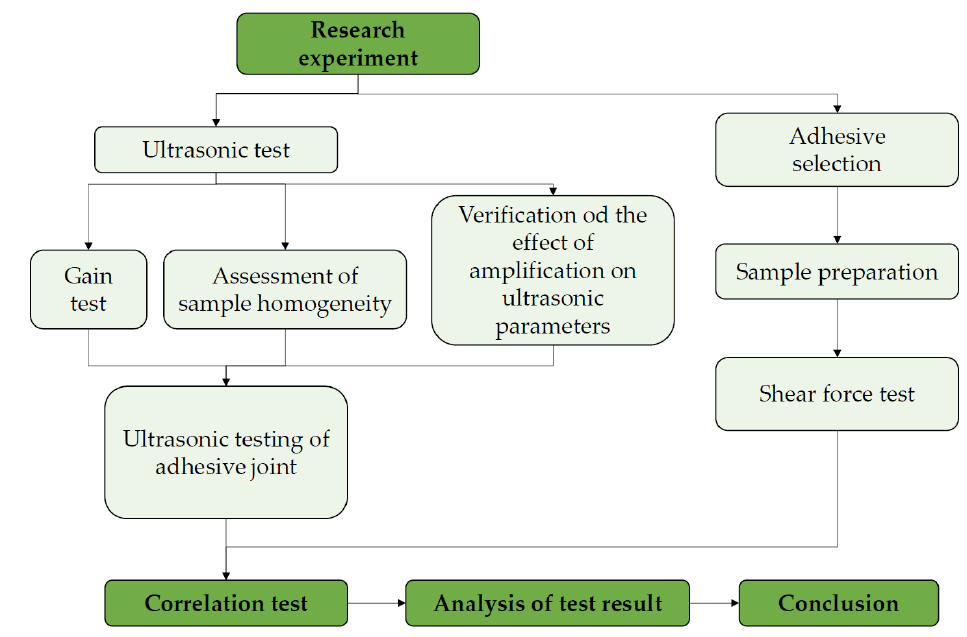
Figure 7. Plan of the